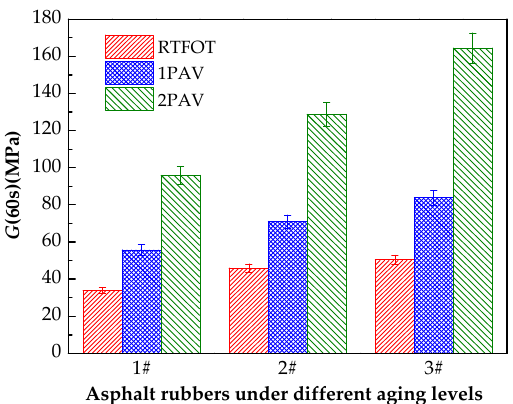
Figure 7. G ( 60s ) for di ff erent aging levels.